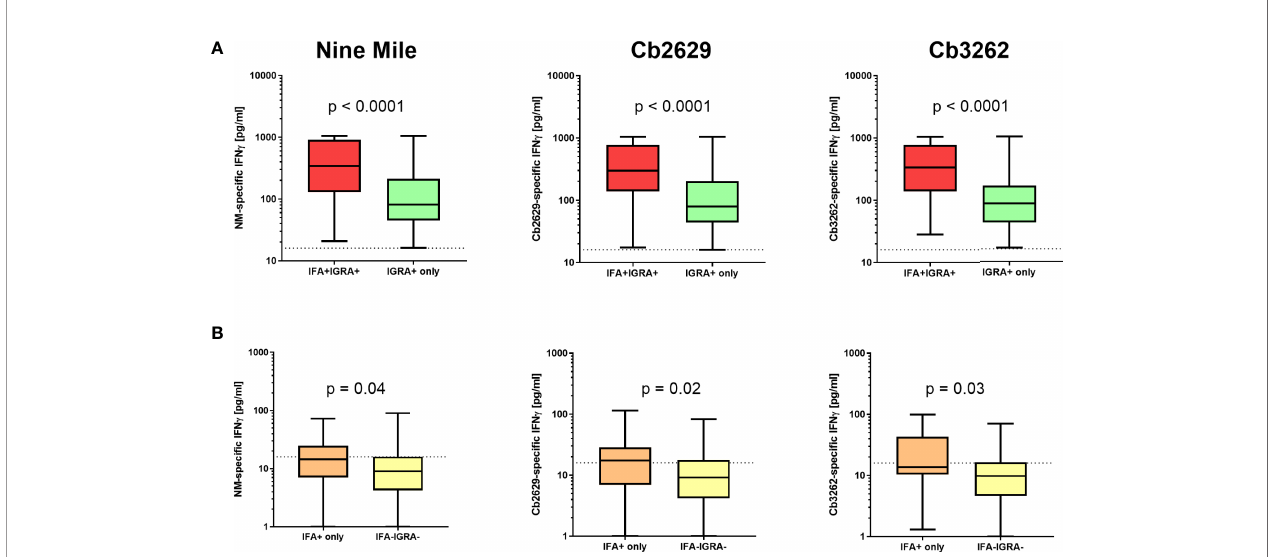
FIGURE 3 | C. burnetii -speci fi c IFN g response induced by Nine Mile, Cb2629 and Cb3262. C. burnetii -speci fi c responses (background corrected for negative controls per donor) are shown for individuals that scored positive (A) or negative (B) by IGRA depending on whether individuals were sero-positive by IFA (red and orange) or not (green and yellow). Groups were compared by Mann-Whitney rank test. The dashed line indicates the positivity cut-off of 16 pg/mL for C. burnetii speci fi c IFN g production. Whisker box plots show boxes with medians and interquartile ranges and whiskers extending from min to max